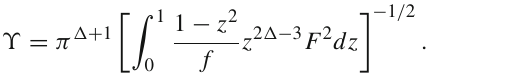
Fig. 3 The condensate as a function of the temperature for differ- ent values of GB parameter α with the fixed mass of the vector field = 3 in the holographic p-wave superfluid model in AdS black m 2 L 2 ef f hole. In each panel the five lines from top to bottom correspond to